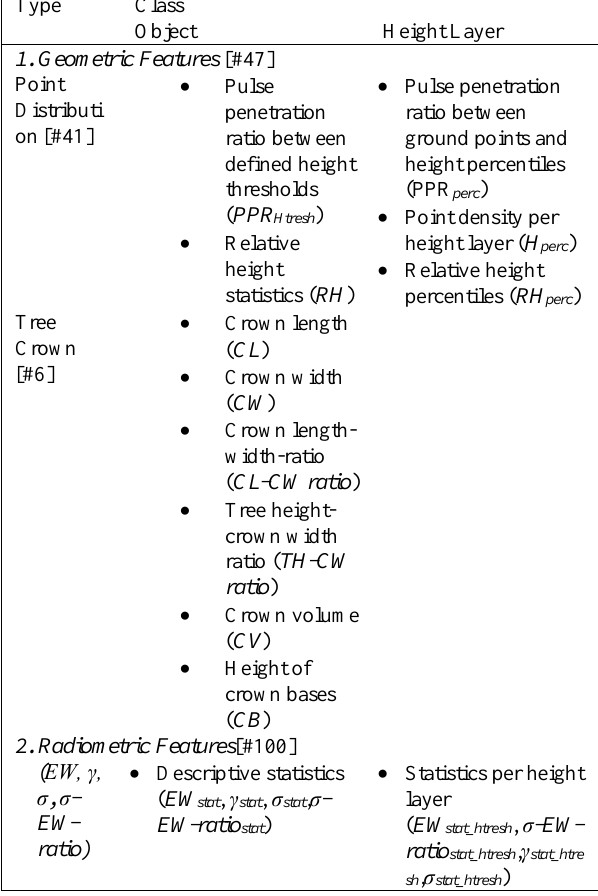
Table 2. Calculated features categorized by the feature types ‘geometric’ and ‘radiometric’ and by the feature classes ‘object’ for single tree segment and ‘height layer’ within the single tree object. The statistical measures are: minimum, maximum, mean, standard deviation, range and coefficient of variation. The total number of features (#) is given in brackets.